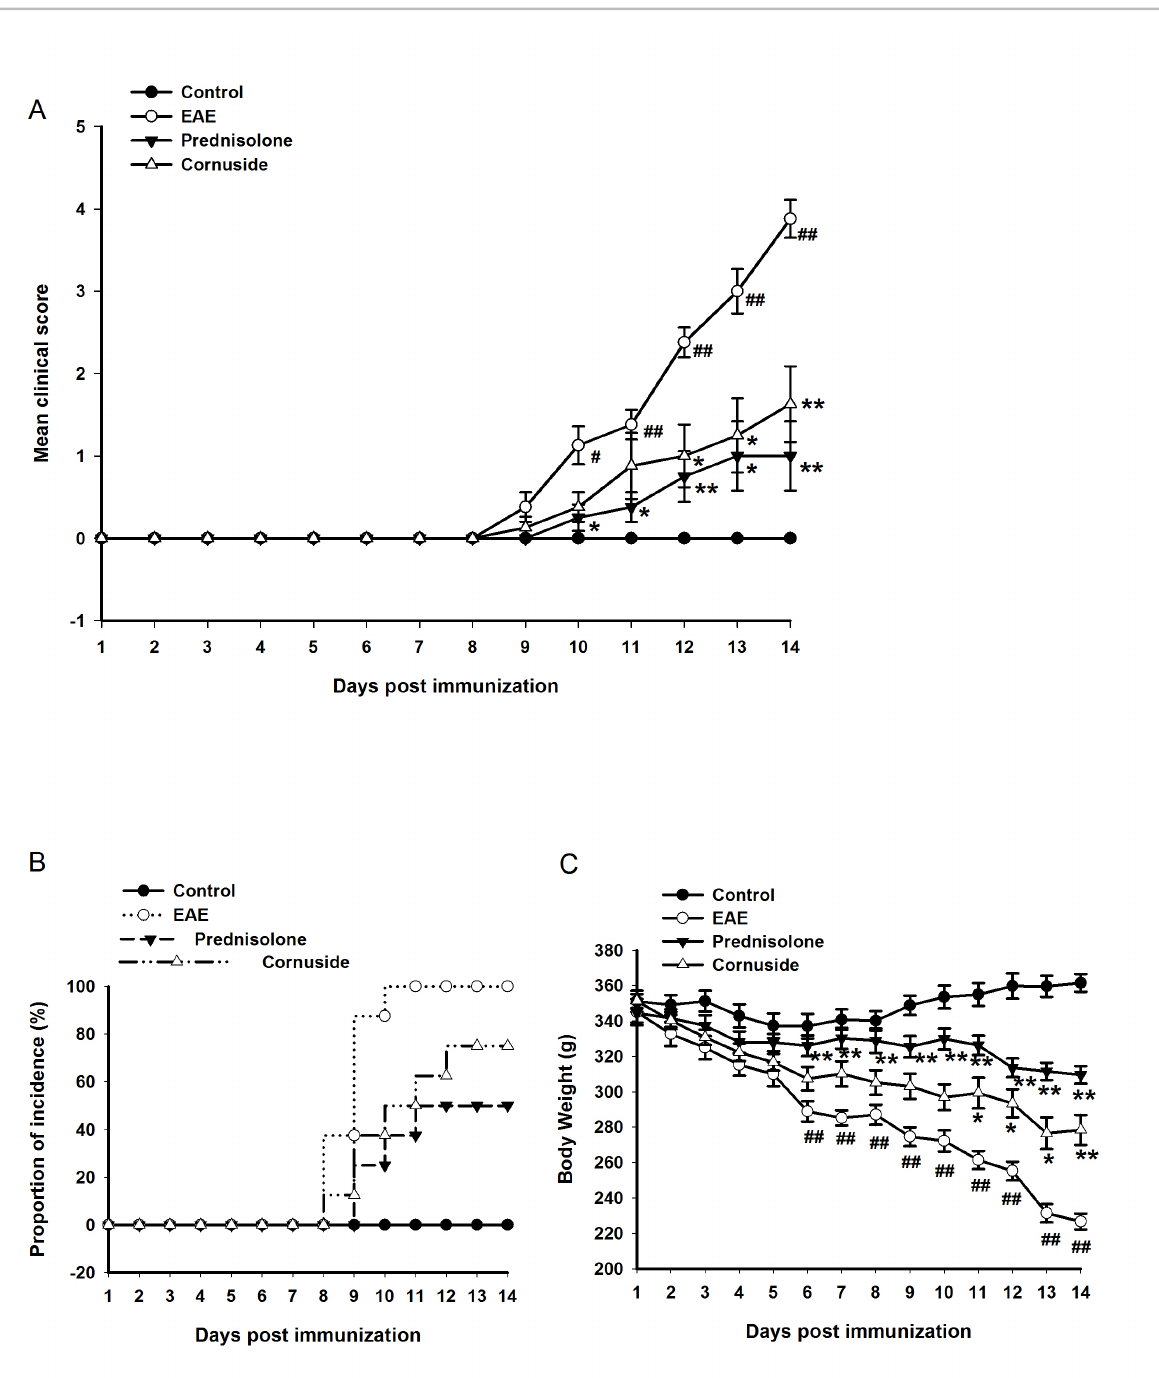
FIGURE 1 - Cornuside ameliorated clinical signs of experimental autoimmune encephalomyelitis (EAE). (A) Clinical scores of neurological deficits. (B) The proportional EAE incidence in rats of the four groups. (C) The body weight of the rats among the groups. * P <0.05, ** P <0.01 for the cornuside or prednisolone group versus the EAE group, # P <0.05, ## P <0.01 for the EAE group versus the control